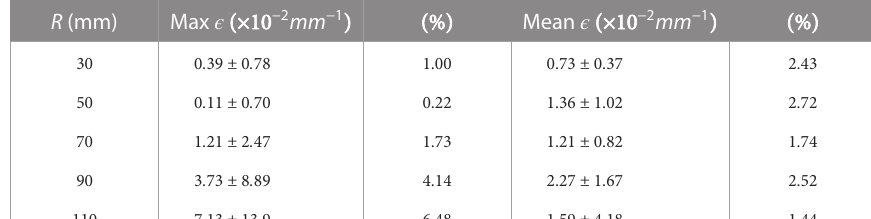
TABLE3 Barefibresensedcurvatureerrors(gratings11–19).